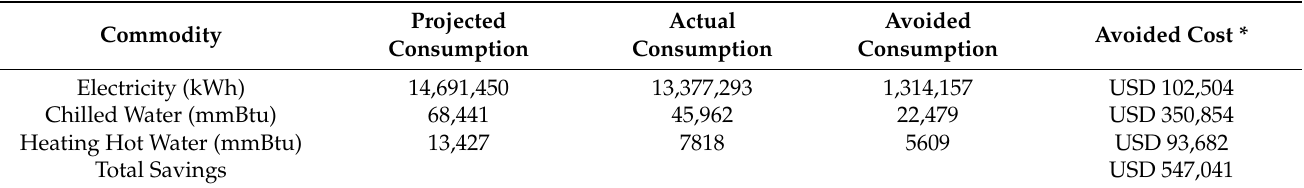
Table 1. The reduction in consumption and dollars saved through this initiative (Source: TAMU Energy Performance Improvement Website).